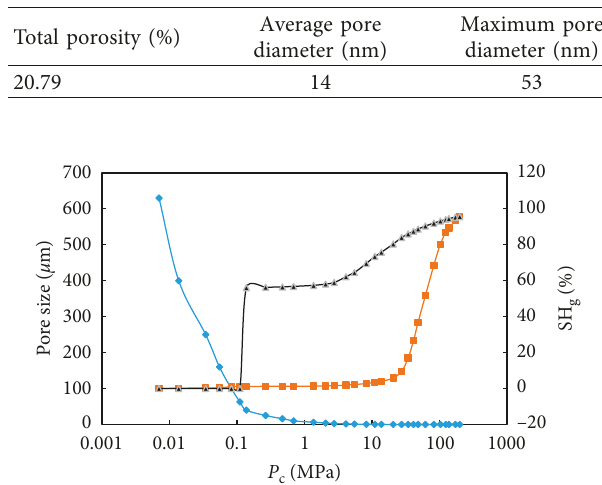
c represents intrusion